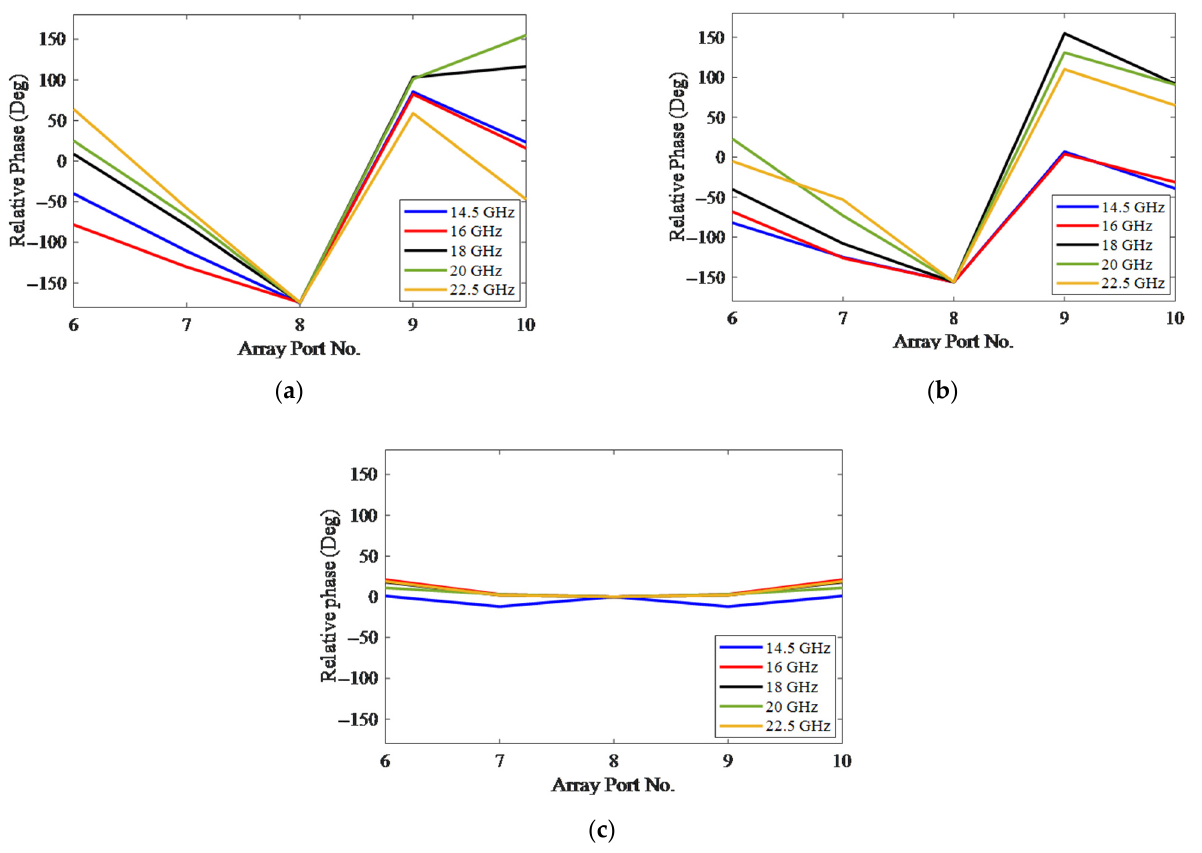
Figure 6. The relative phases of the output array ports in five frequencies and for the excitation of